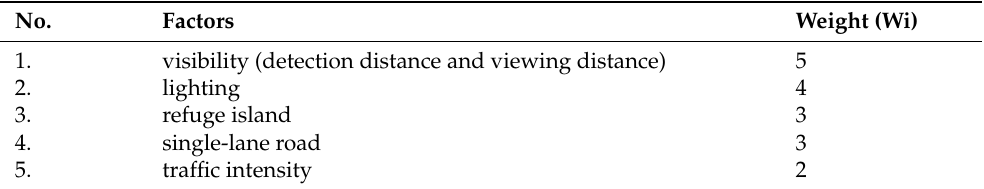
Table 1. Point weights of the main factors according to the adopted methodology.